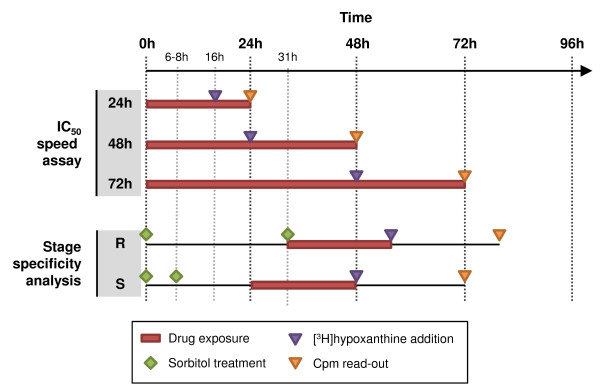
Schematic representation of the twoin vitroassays. The “IC50 speed assay” and “stage-specificity analysis” are performed with unsynchronized and synchronized parasite cultures, respectively. R, rings; S, schizonts.